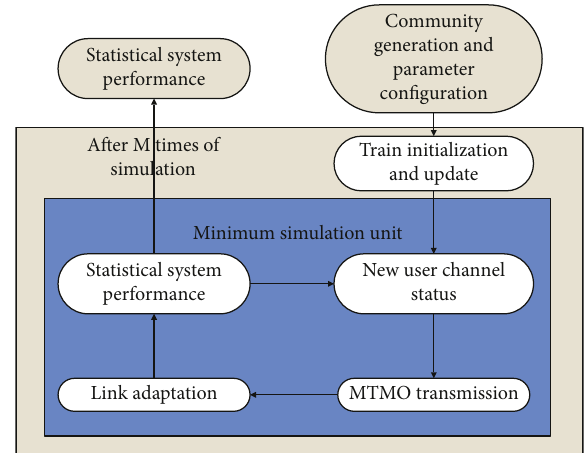
Figure 4: Model simulation frame of the system.